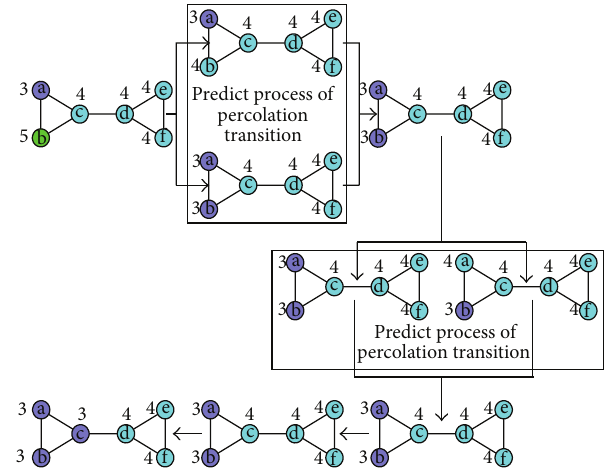
Figure 5: Label propagation with prediction